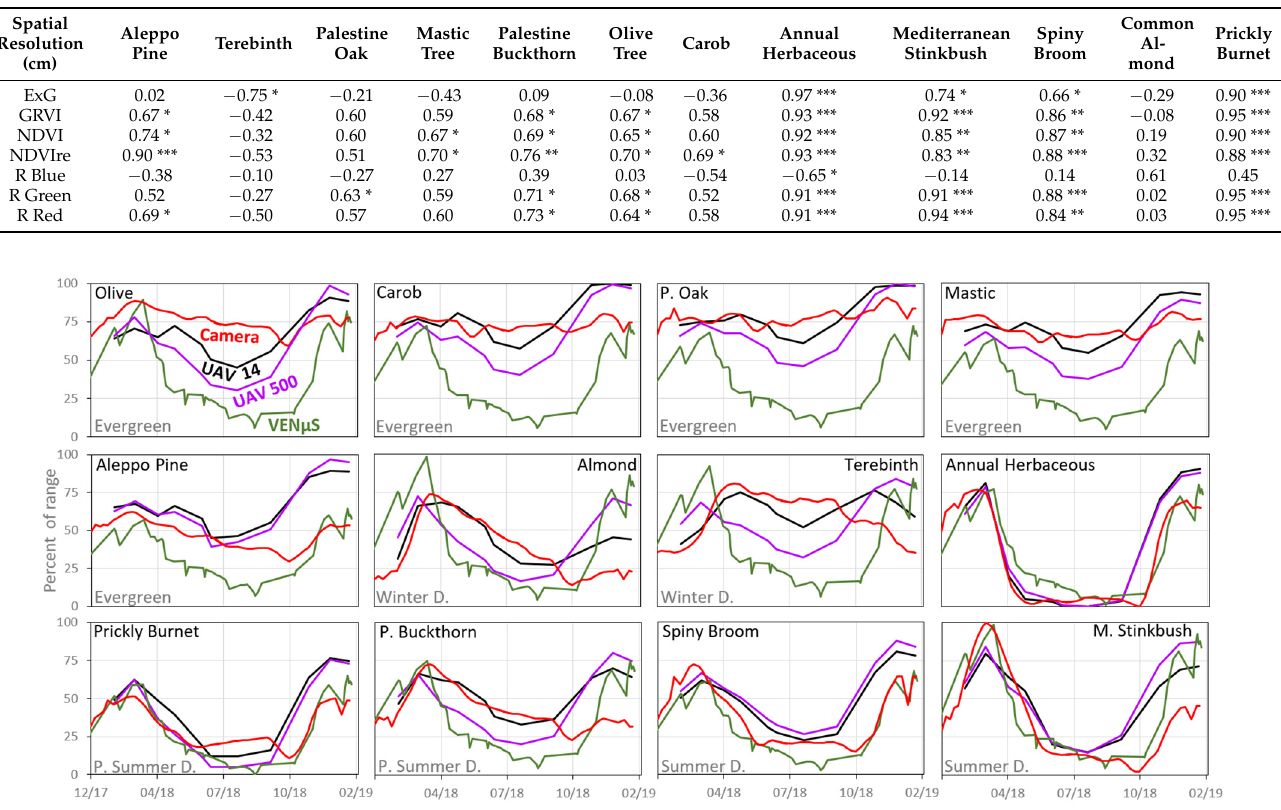
Figure 10. Standardized mean NDVI values of the 12 species based on the ground photos after preprocessing (57 dates), UAV data (11 dates, 14 and 500 cm), and VEN μ S acquisitions (47 dates, nominal resolution of 5.3 m at nadir, effective resolution of about 7.5 m due to the off-nadir acquisition angle of 29.7°). The y -axis represents the index mean value as a percent of the possible range of values. Table 5. Pearson correlation coefficients of seven spectral indices mean value for each species per date (10 dates), between values derived from the UAV data and those from VEN μ S. The asterisks indicate the statistical significance as follows: *